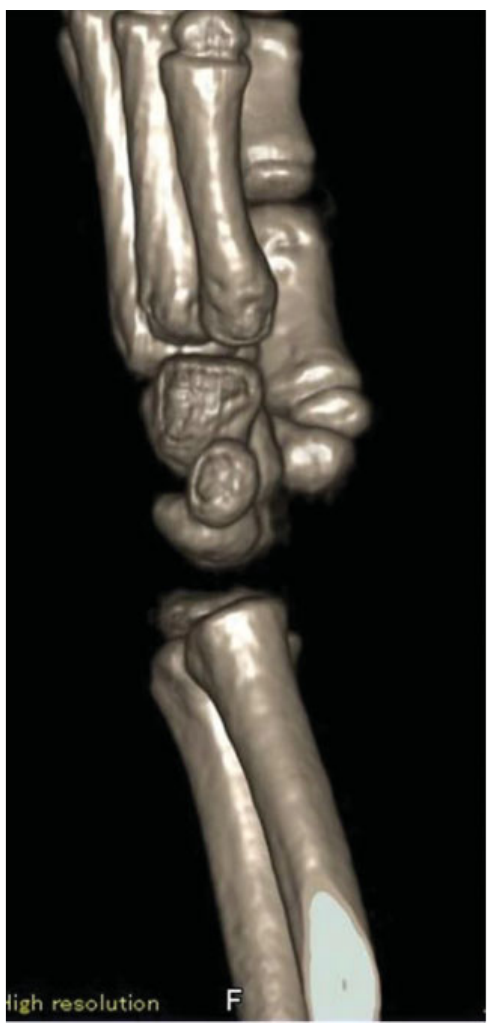
Fig. 4 Computed tomographic scan after surgery, lateral